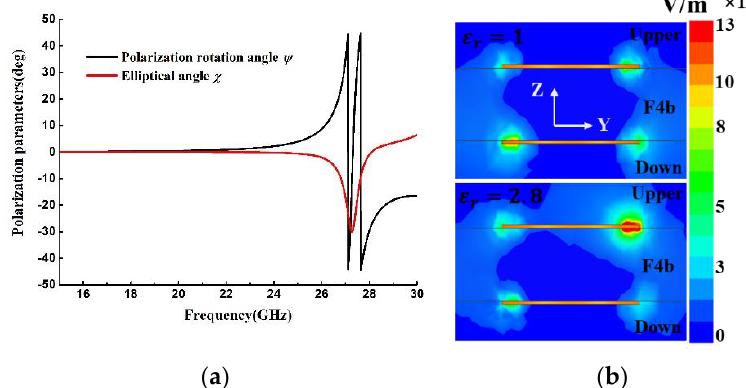
Figure 3. ( a ) Simulated EA and PRA of the transmitted wave with y-polarized incidence. ( b ) Electric field distributions of the meta-surface covered with a sample with the dielectric constant of 2.8 and the thickness of 0.5 mm.